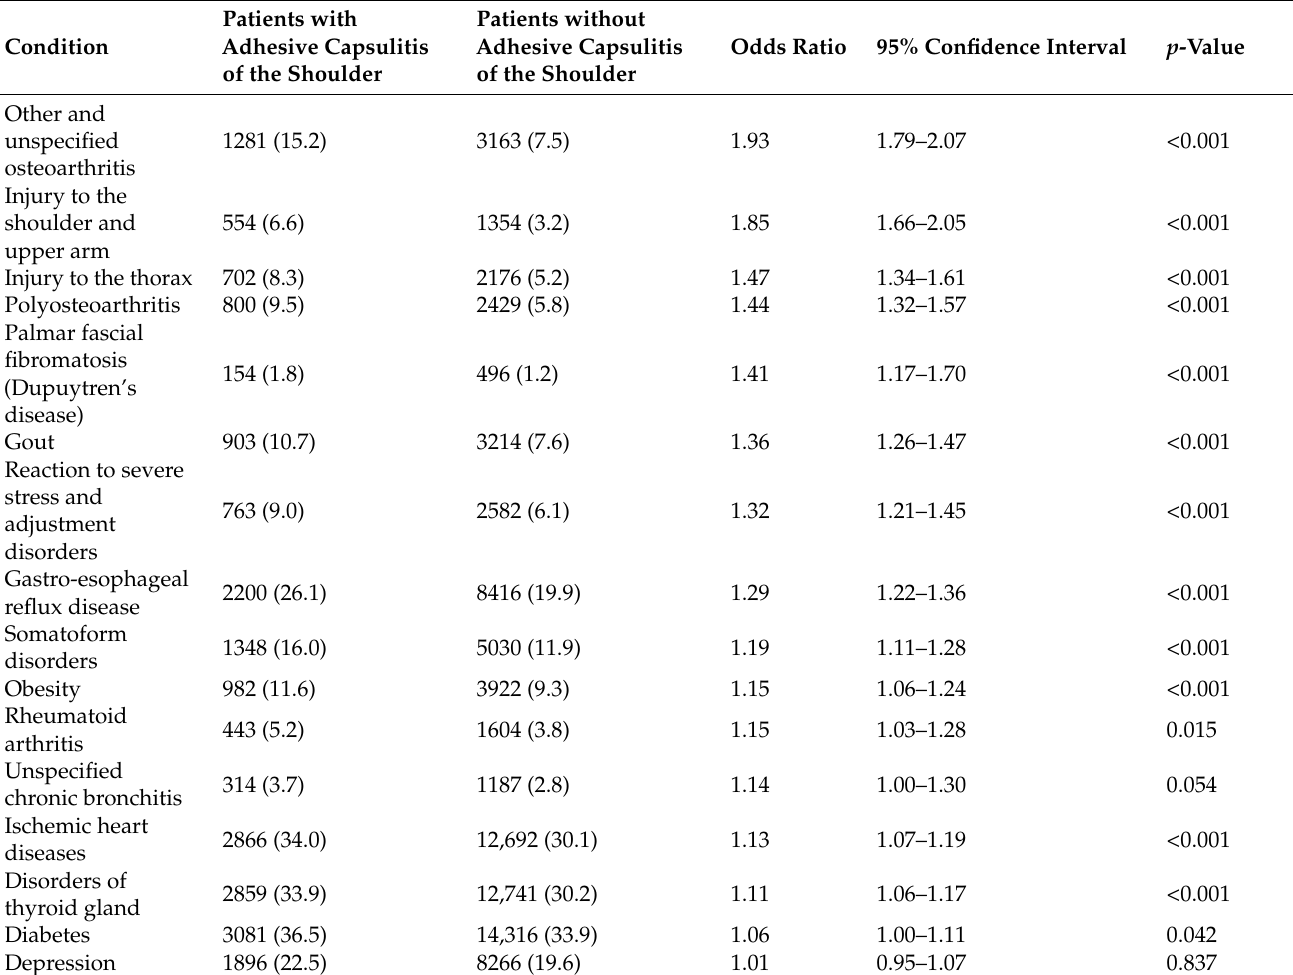
Table 2. Physical and psychiatric conditions significantly associated with adhesive capsulitis of the shoulder in patients aged ≥ 65 years from Germany (adjusted logistic regression